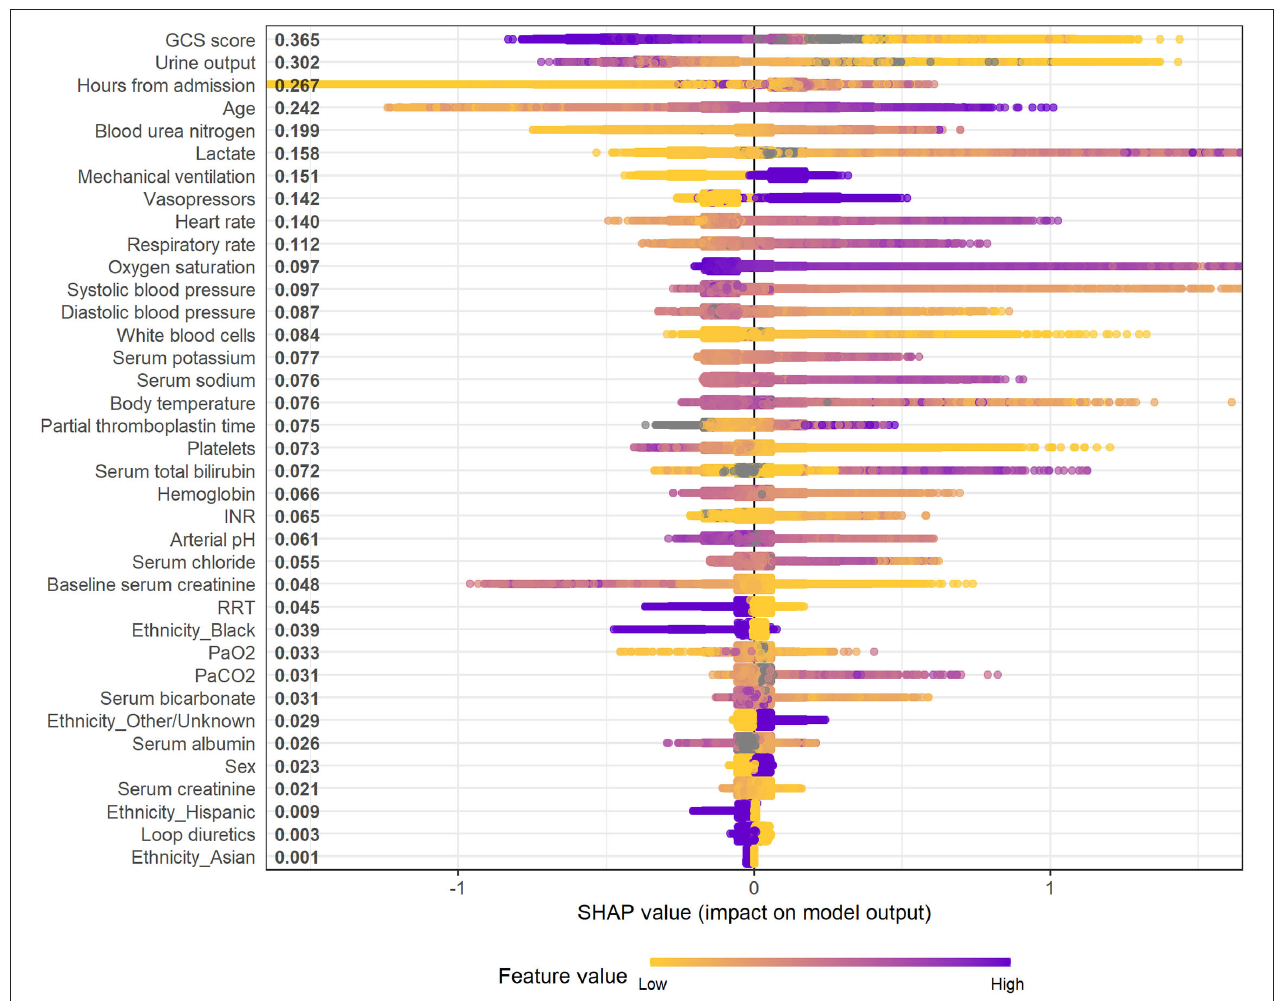
FIGURE 5 | SHAP summary plot of the XGBoost model for mortality in the following 48h. Higher SHAP value means a higher probability of death within the next 48h. Purple represents higher feature values and yellow represents lower feature values. A dot is created for each feature attribution in calculating the output risk for each observation. GCS, glasgow coma scale; INR, international normalized ratio; RRT, renal replacement therapy; PaO 2 , partial pressure of arterial oxygen; PaCO 2 , partial pressure of arterial carbon